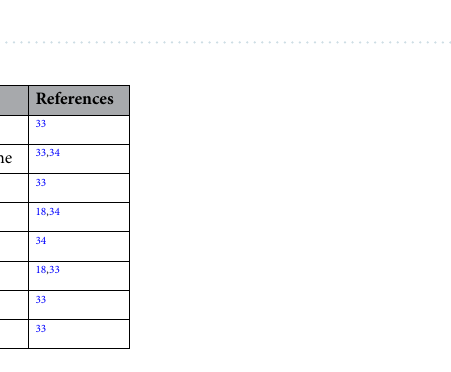
Table 2. Assignment of spectral peaks contributing to discrimination of infected samples from uninfected